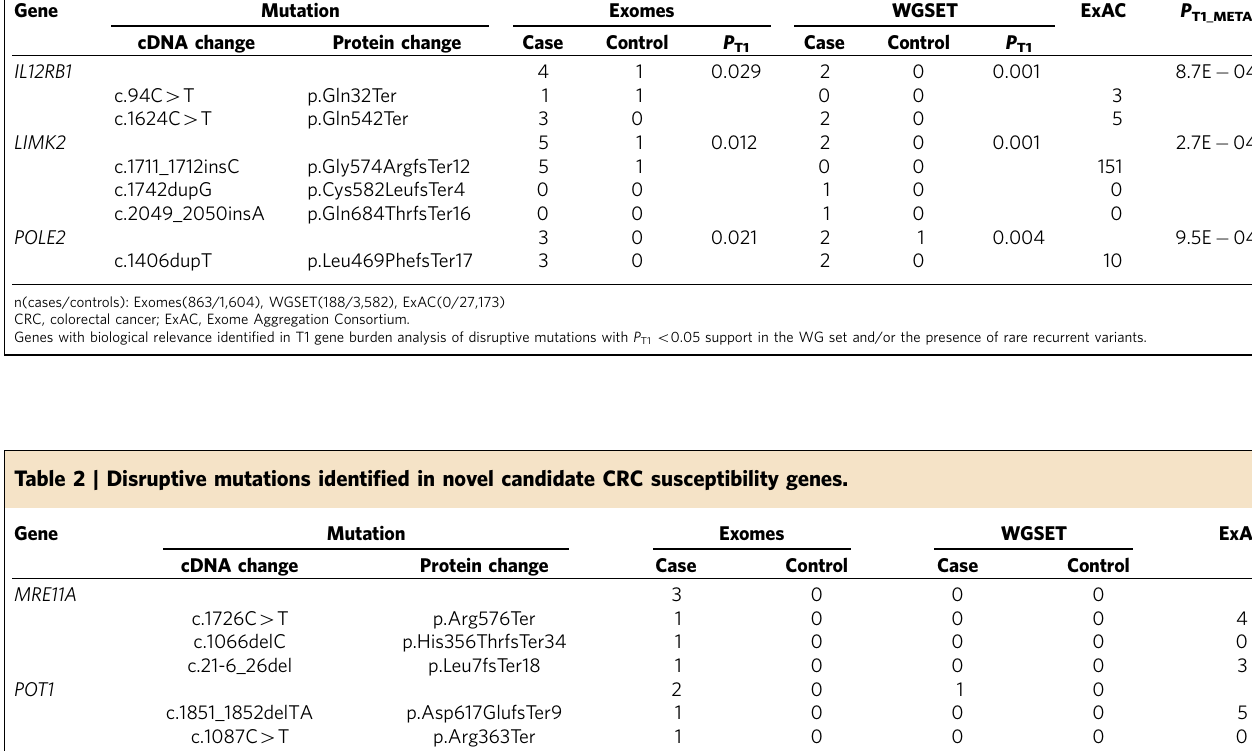
Table 1 | Disruptive mutations identified in candidate CRC susceptibility genes with biological relevance. Gene